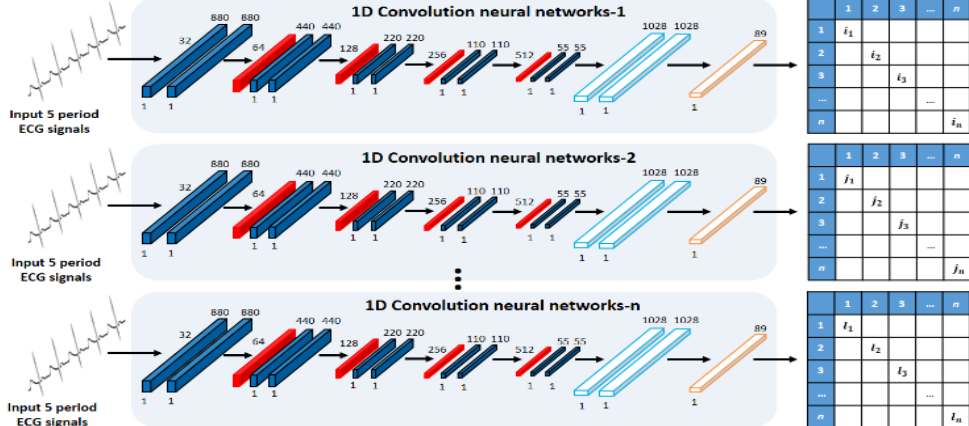
Figure 5. Single CNN of parallel structure.